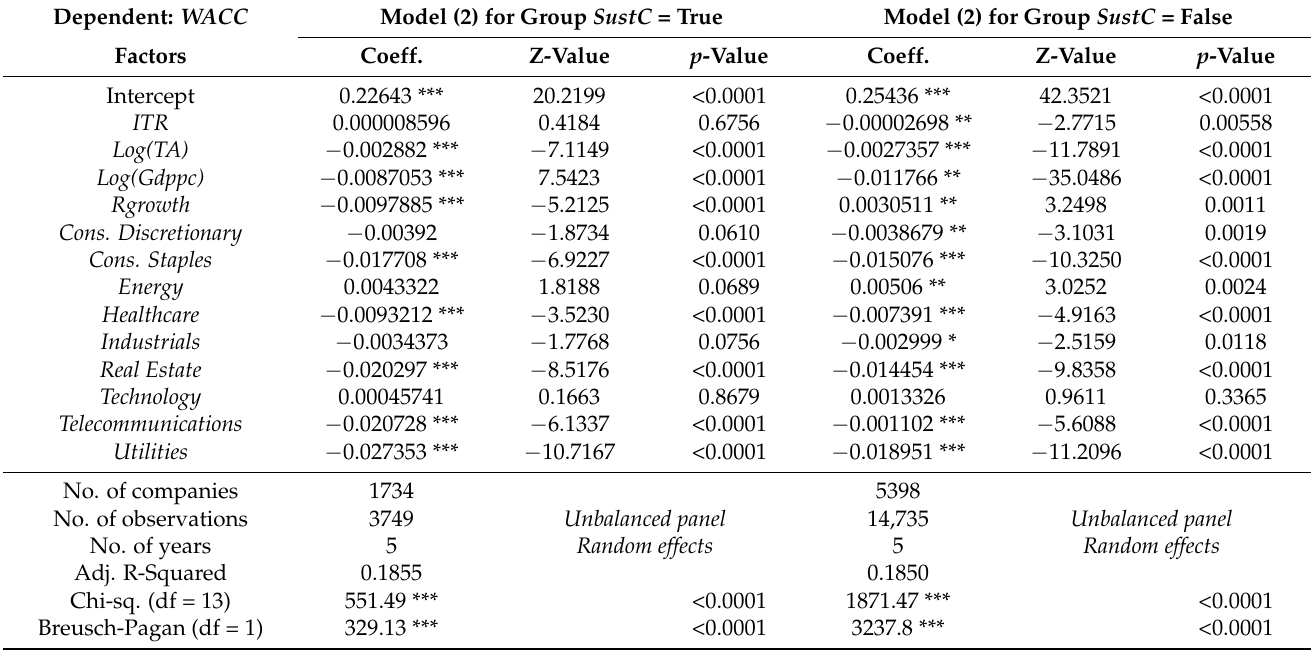
Table 13. Panel regression results for the weighted average cost of capital ( WACC) as the dependent variable, with sample companies grouped by SustC .